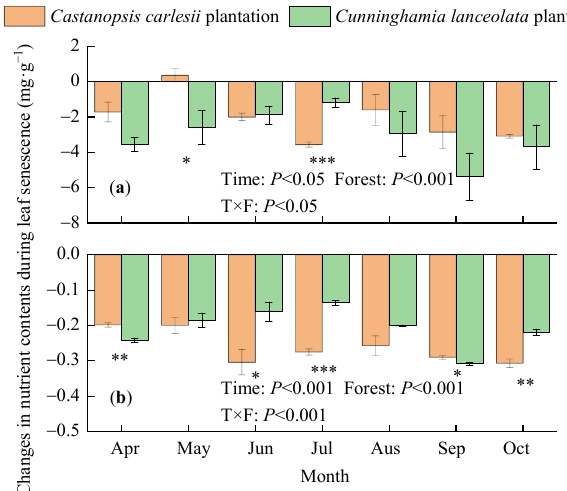
Figure 3. Changes in N ( a ) and P contents ( b ) during leaf senescence. Each column represents the average value of the three replicates ( n = 3). Error bars represent standard errors (SE) . The p values show the results from repeated measures ANOVA testing for the effect of forest type over time. Asterisks denote significant differences between forest types: * p < 0.05, ** p < 0.01, *** p < 0.001.